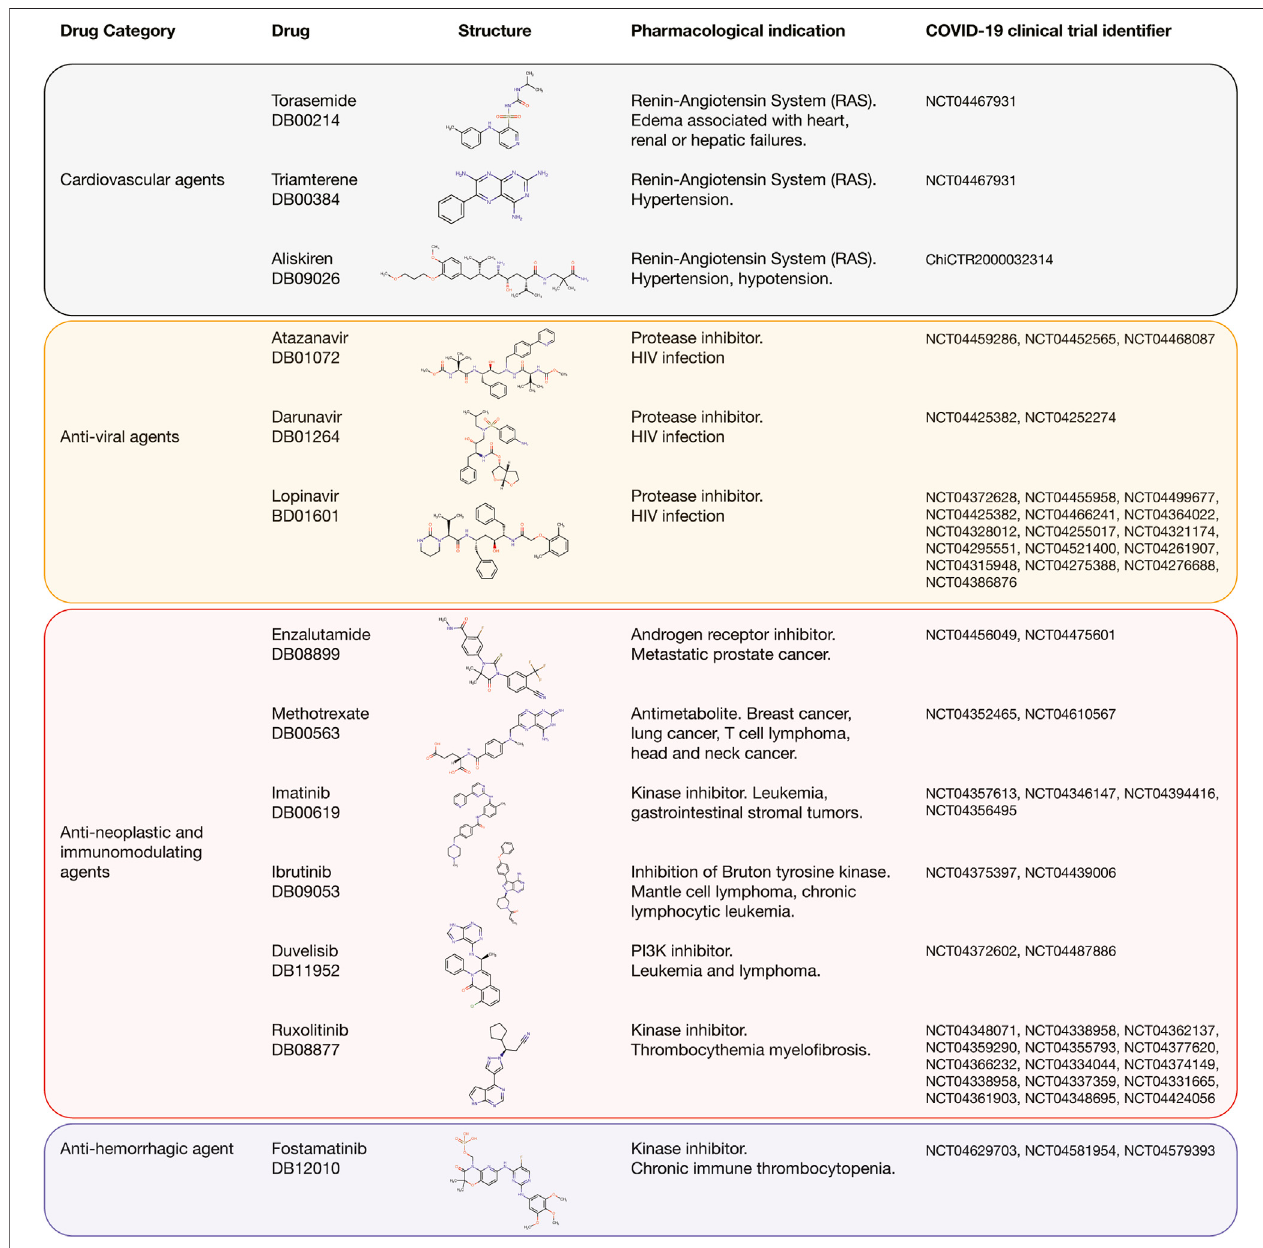
FIGURE 9 | Best-predicted approved drugs involved in COVID-19 clinical trials. Cardiovascular agents, anti-viral agents, anti-neoplastic and immunomodulating agents, and anti-hemorrhagic agent with their respective clinical trial identi fi er number, pharmacological indication, and chemical structure according to DrugBank.